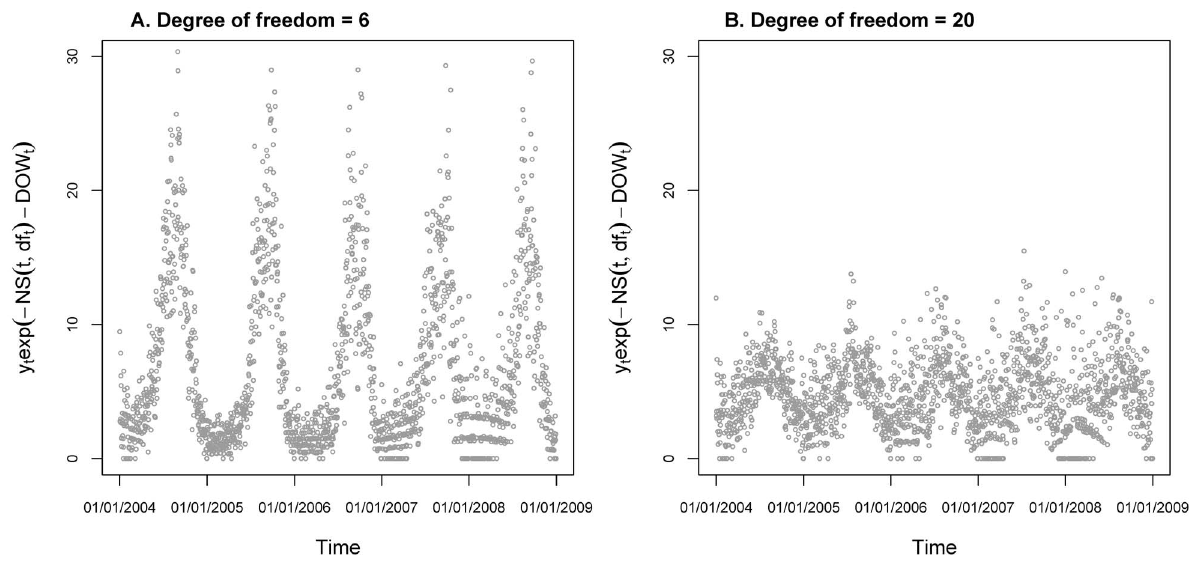
Figure 4. Scatter plot of y t exp(-NS(t,df t )-DOW t ) vs. Time by GAM model. From expression (5), we shall assume that the term m t exp(- NS(t,df t )-DOW t ) will have stable seasonality which does not change in different years. To achieve this property we need to check the seasonality of the term y t exp(-NS(t,df t )-DOW t ) by the scatter plot under the certain selection of the degree of freedom for the natural spline functions. The figure shows good seasonality with df t =6 in part A and week seasonality with df t =20 in part B.